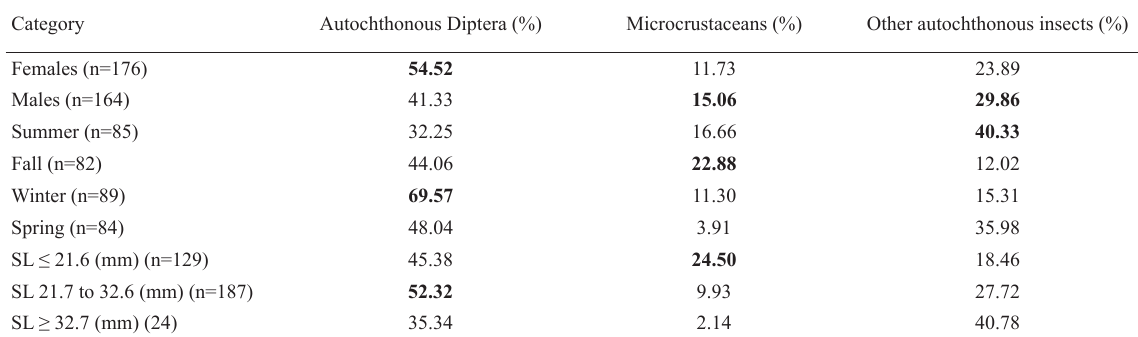
Table 3. Annual volume in percentage of the main food items consumed by Atlantirivulus riograndensis in relation to sex, seasonality, and ontogeny. Individuals collected at the Banhado dos Pachecos wildlife refuge in the city of Viamão, Rio Grande do Sul, Brazil, in 2012. The values in bold represent the category in which each item was consumed with the highest percentages. Standard Length